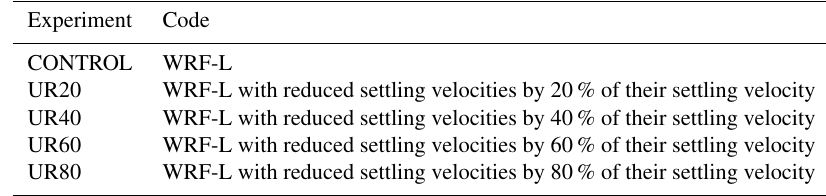
(cid:18) d V = V tot √ dln D 2 π ln σ g